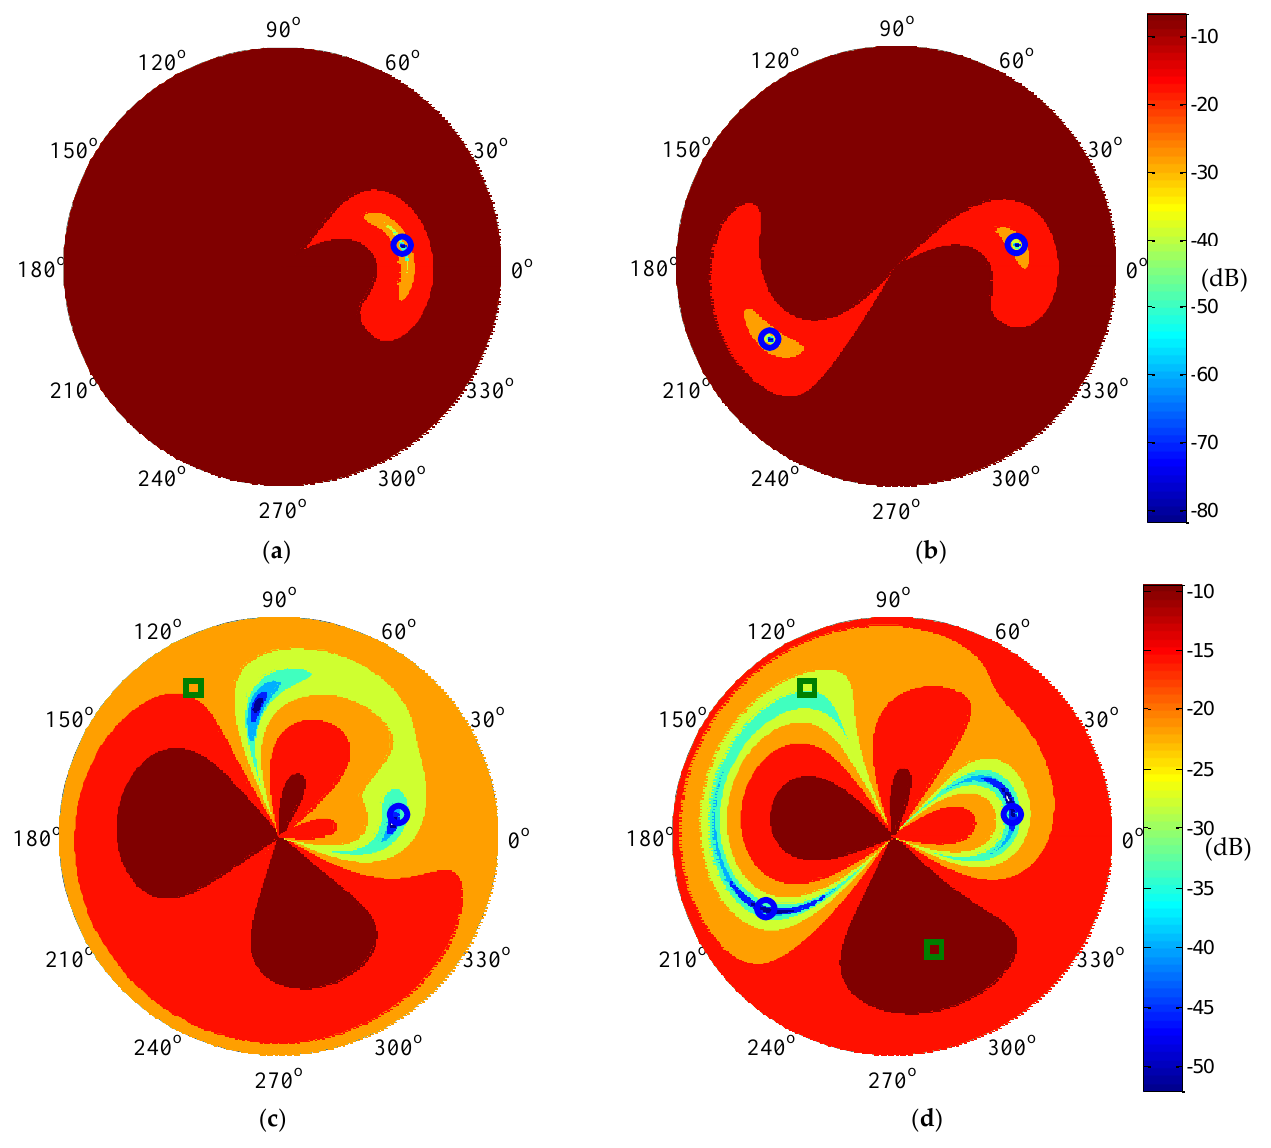
Figure 10. Array patterns in STAP: ( a ) one jammer without multipath, ( b ) two jammers without multipath, ( c ) one jammer with one multipath, and ( d ) two jammers with two multipath. In the above figure, the interference directions are marked with the blue cycle, and the multipath directions are marked with the green square. Under the condition of no multipath, the synthetic array pattern can accurately form the null in the interference directions. When the multipath is present, the synthetic array pattern can also form the null in the interference direction, but the null is not formed in the multipath direction. The interference suppression performance in the four cases is shown in Table 5. Table 5. ICR with STAP in different condition.